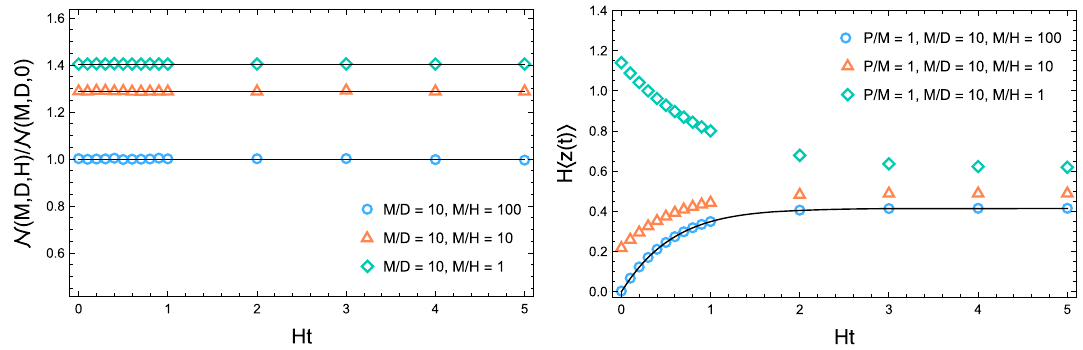
(see Eq. (21)). Right: Numerical calculation of (cid:7) z ( t ) (cid:5) , where the black solid curve corresponds to the classical trajectory z ( t ) (see Eq.